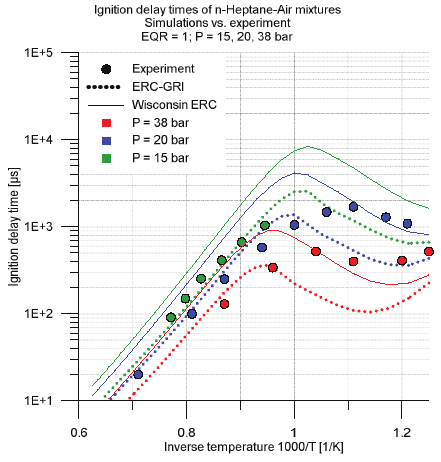
Fig. 3. Validation of IDTs for n-heptane/air mixtures